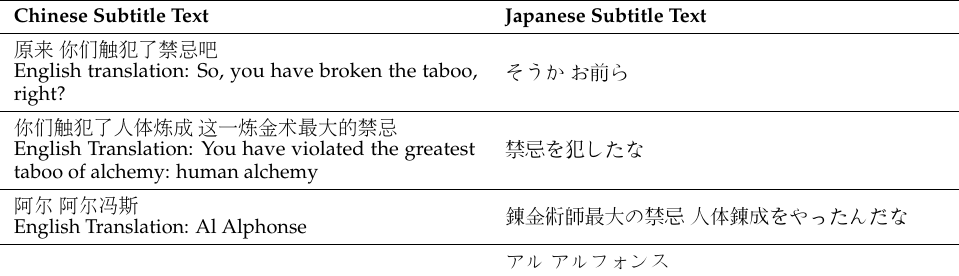
Table 4. Examples of one-to-many and many-to-one errors.